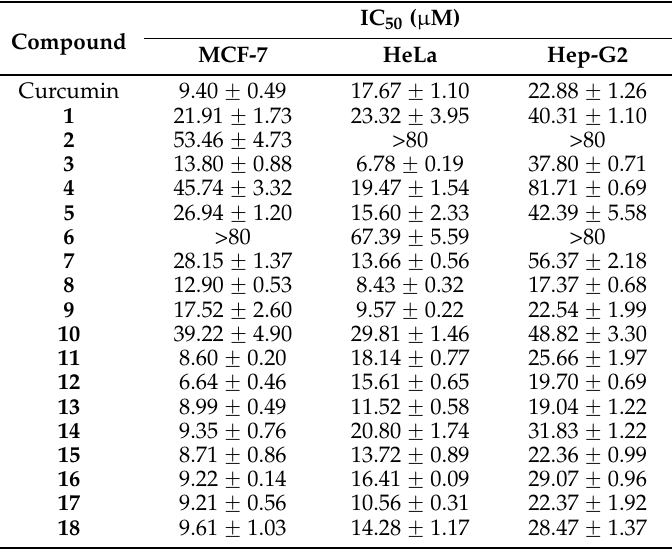
Table 1. Antitumor cell line growth activities of compounds against three tumor cell lines in vitro. Data are expressed as mean ˘ SD ( n = 3).